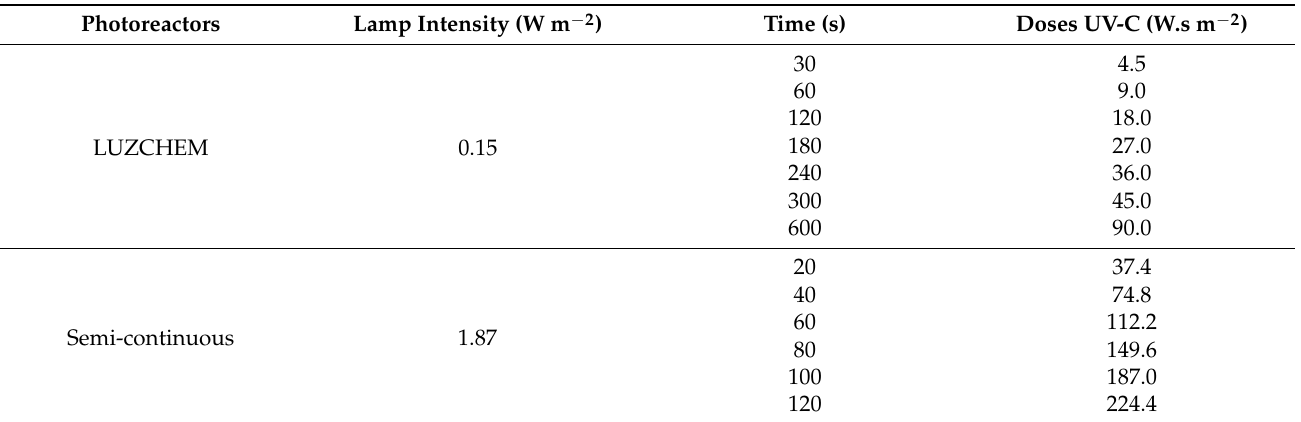
Table 7. The UV doses applied according to the LUZCHEM reactor and semicontinuous